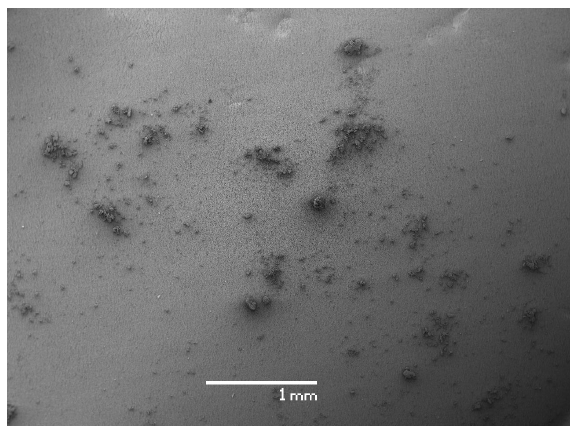
Figure 8. Scanning electron microscope (SEM) image (uncoated, backscattered electron imaging, low vacuum) of aggregates